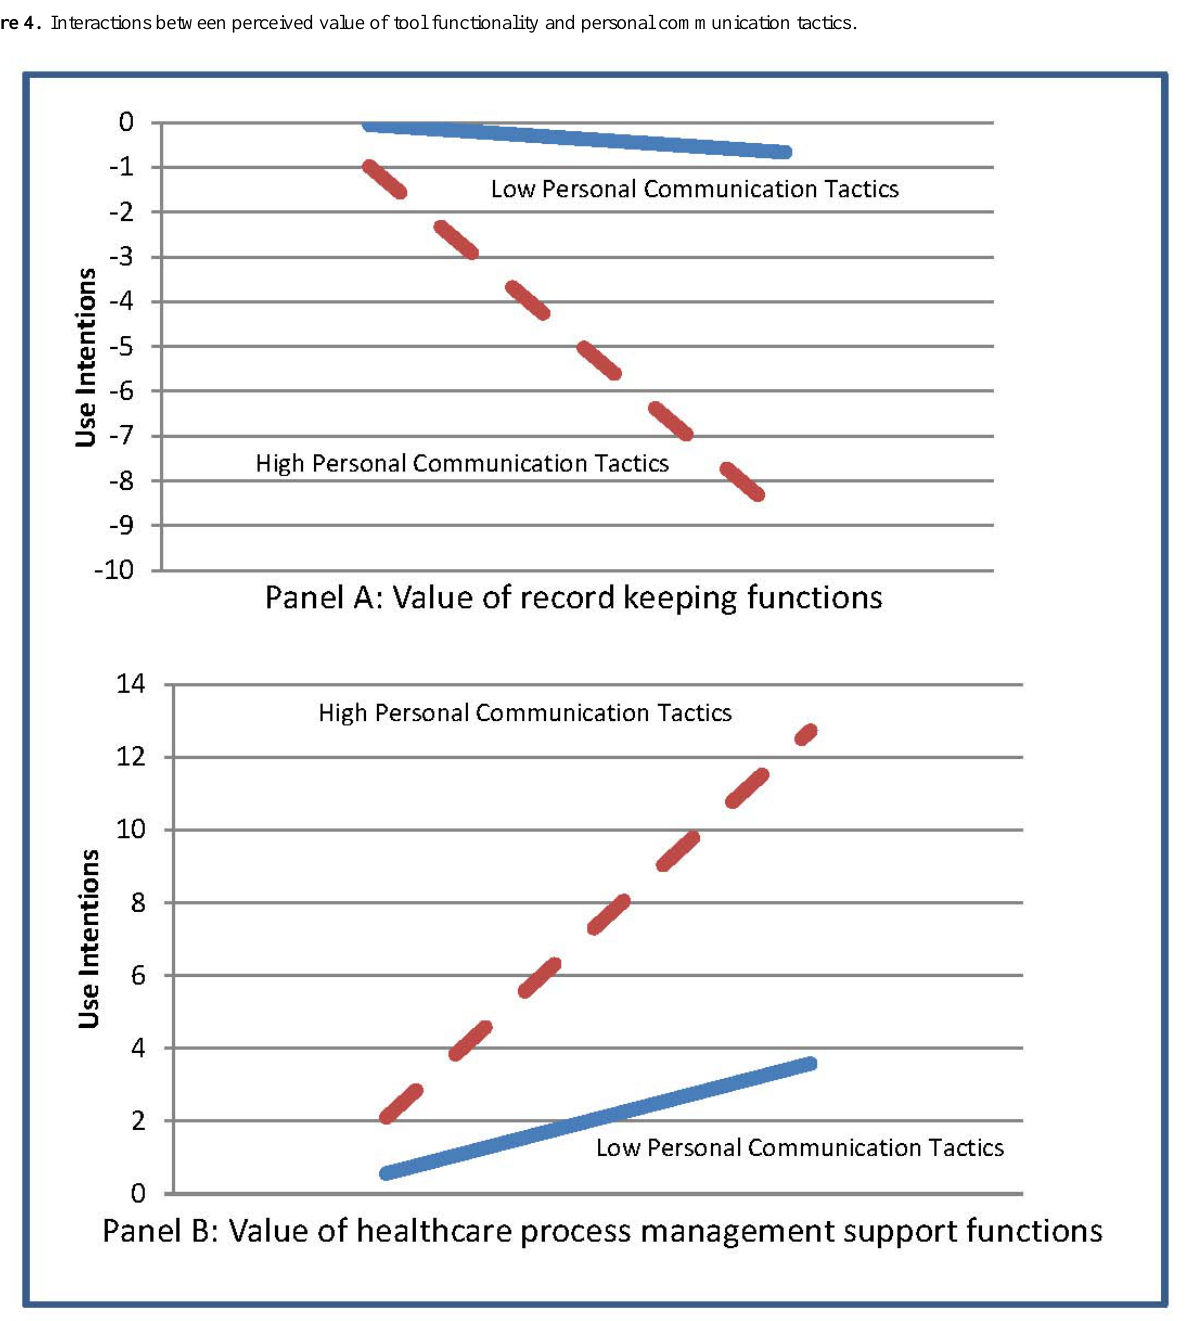
Figure 4. Interactions between perceived value of tool functionality and personal communication